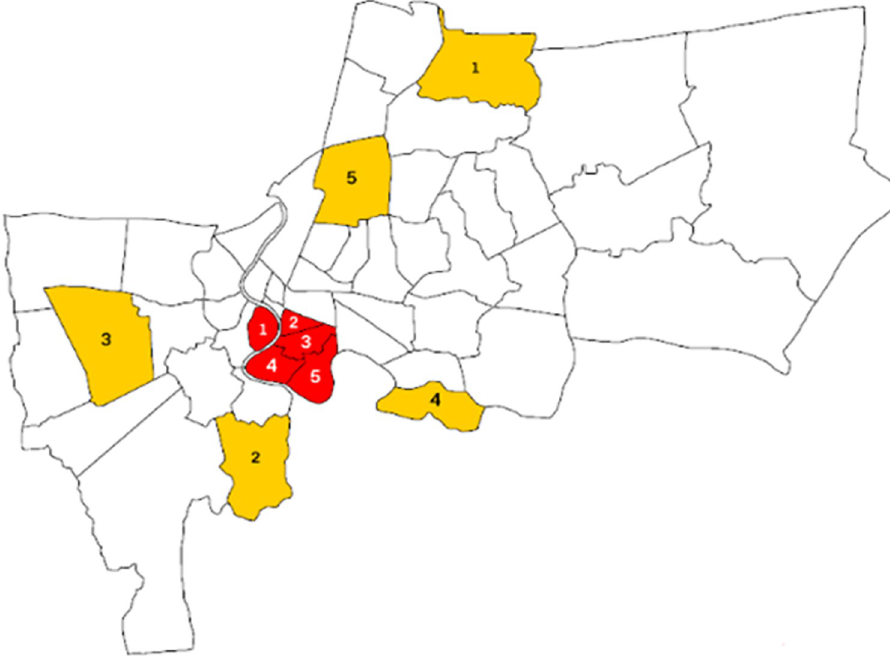
Fig 4. Map of Bangkok highlighting the top five districts with the highest and lowest numbers in the unprotected group. Districts with the highest unprotected group are illustrated in red: 1.Yannawa (19.4%), 2.Klong San (9.37%), 3. Sathorn (9.18%), 4.Bang Kholaem (7.62%), 5.Bang Rak (7.55%). Districts with the lowest unprotected group are illustrated in yellow: 1. Saimai (1.20%), 2. Thung Kru (1.46%), 3. Bang Khae (2.07%), 4. Bang Na (2.34%), 5. Chatuchak